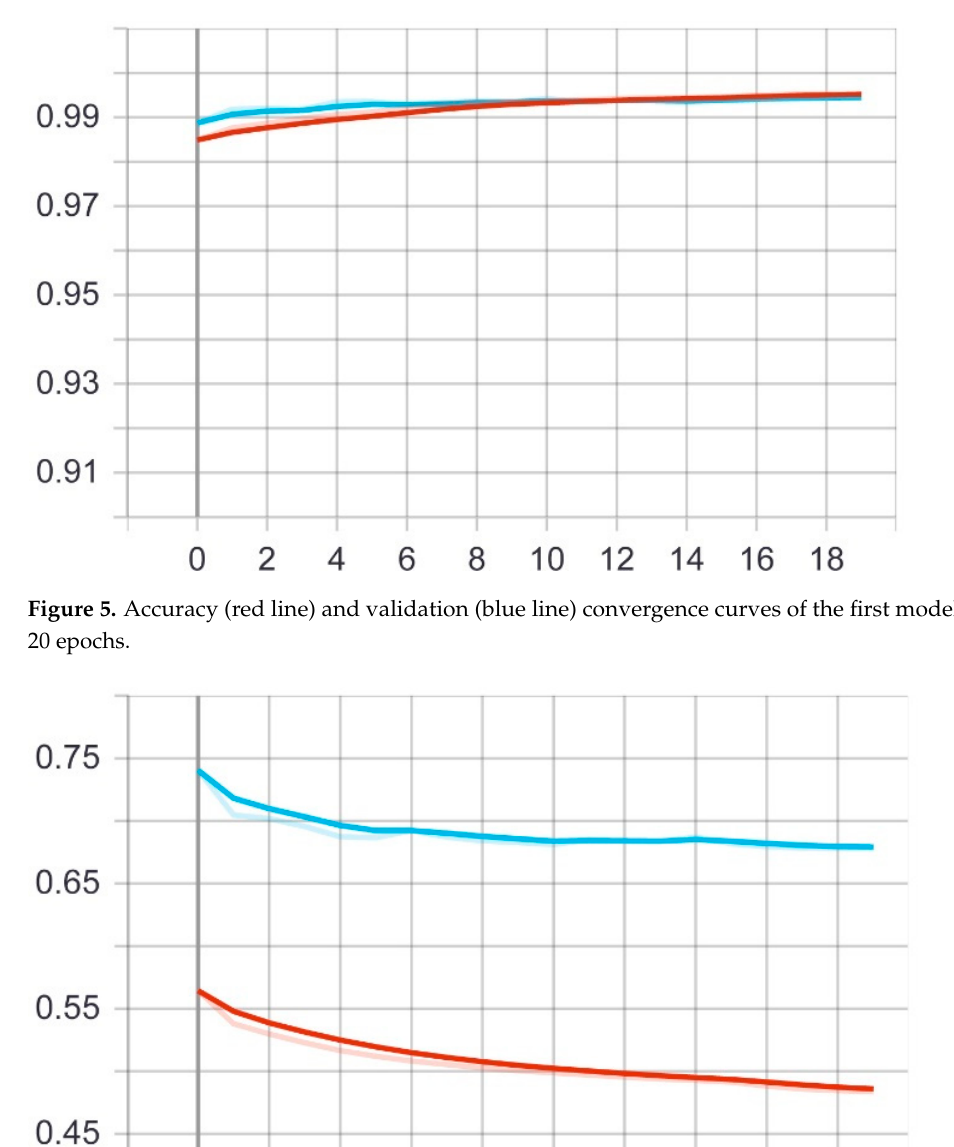
Table 1. The overall performance of the first model on LiTS